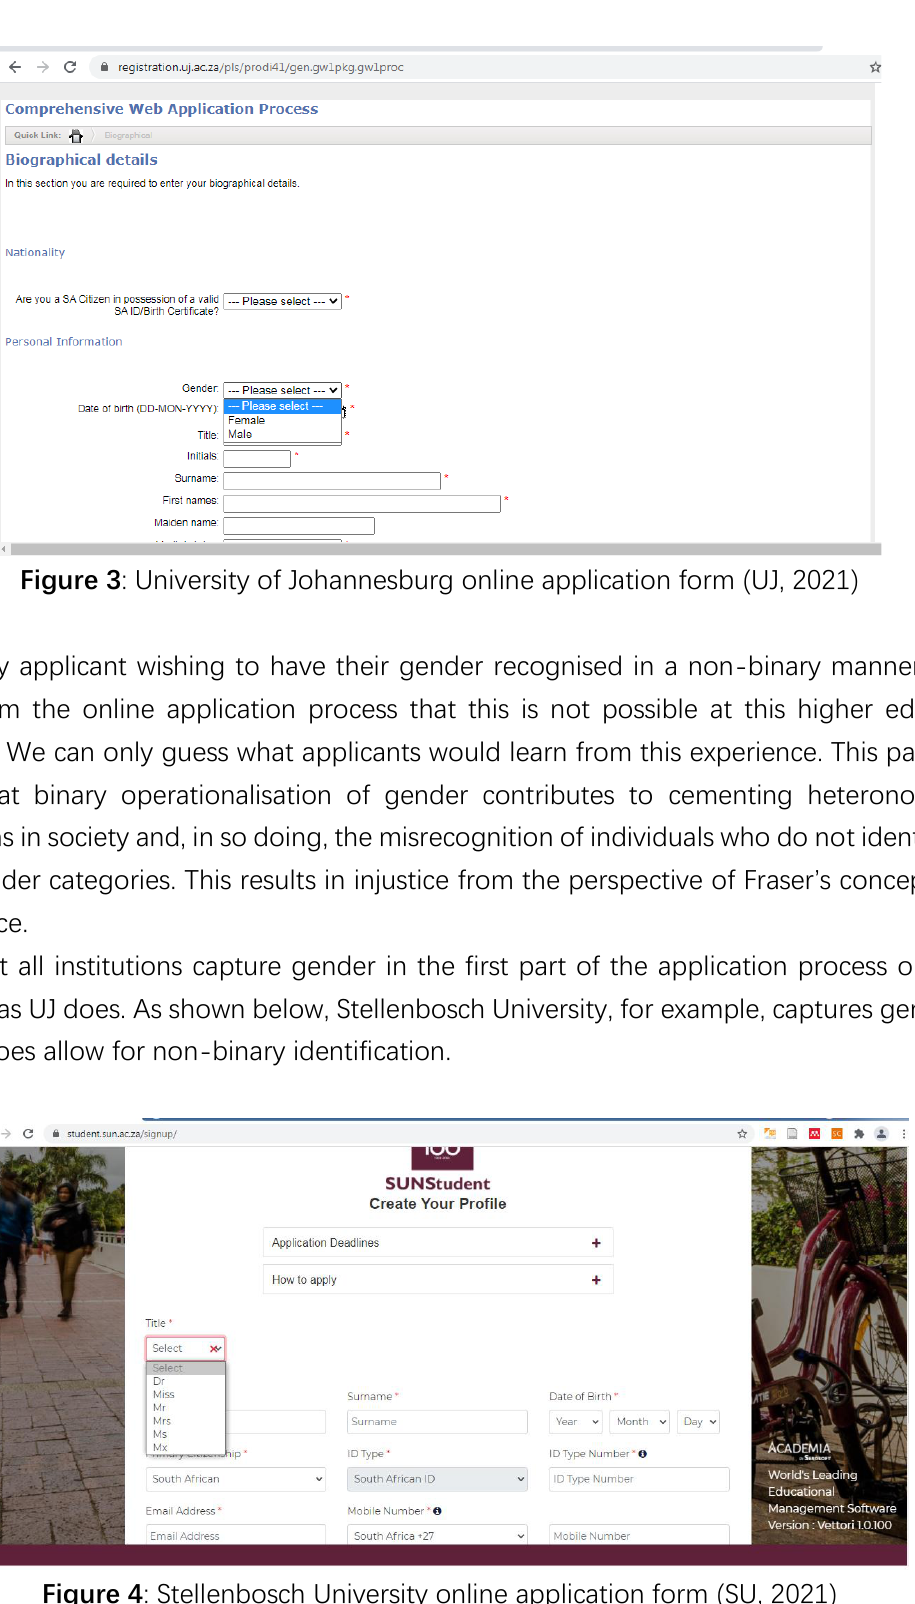
Figure 4 : Stellenbosch University online application form (SU,